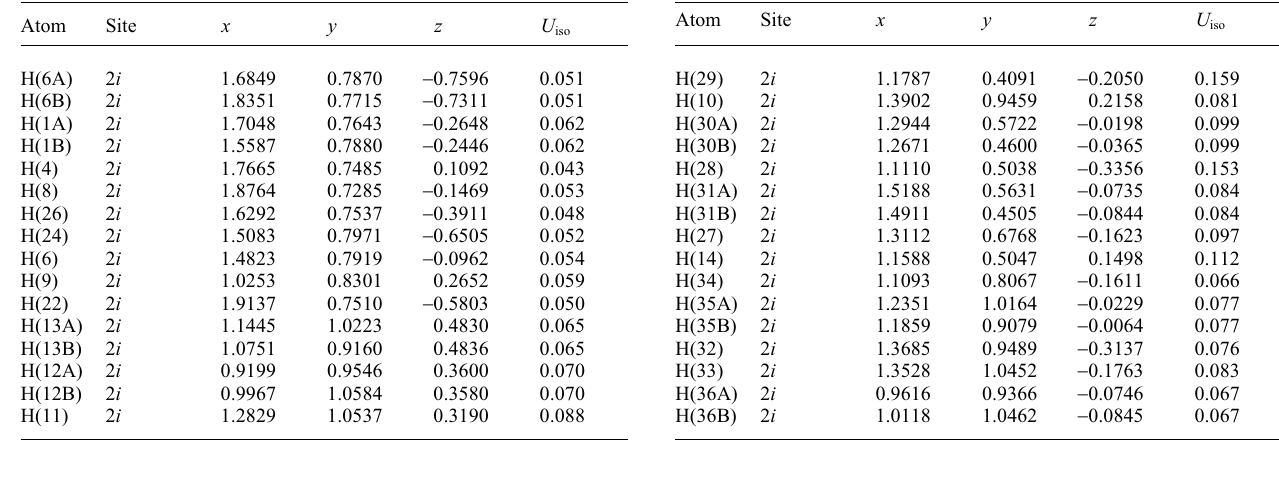
Table 3. Atomic coordinates and displacement parameters (in Å 2 ).